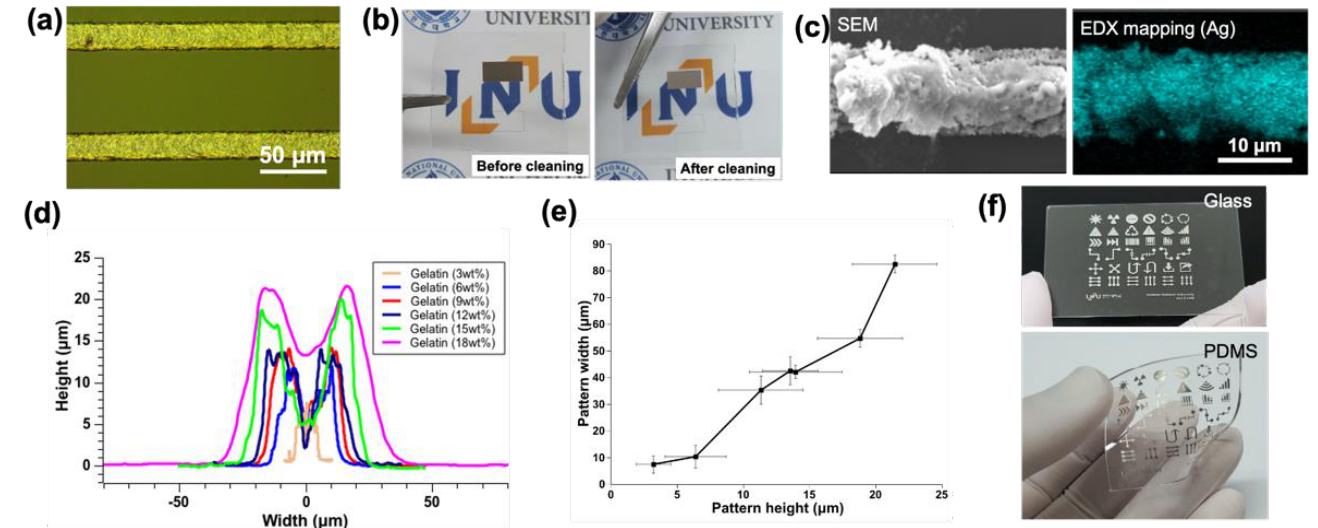
Figure 4. Patterning process using laser-direct writing. ( a ) Optical image of a sintered pattern on the glass, ( b ) image before/after postprocessing after laser processing, ( c ) SEM image and element mapping image using SEM-EDX, ( d ) cross-sectional profile of the pattern by surface profiler, ( e ) relationship between height and width of the pattern, and ( f ) diverse shape pattern on glass and PDMS.